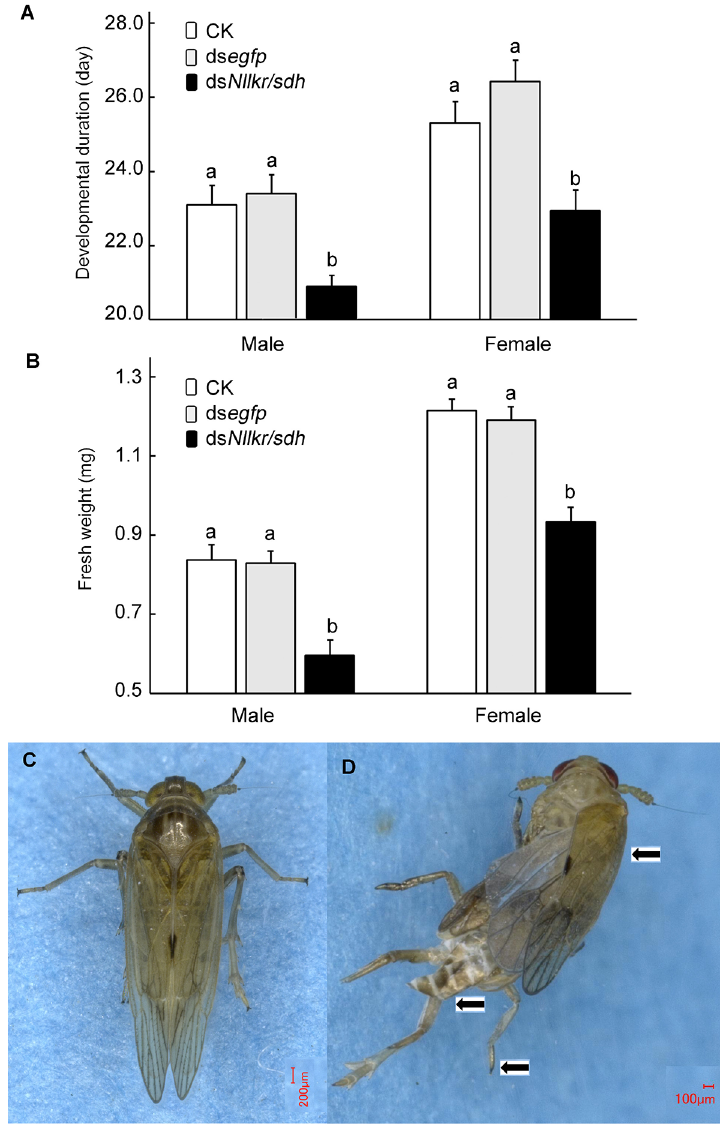
Fig 7. Ingestion of ds Nllkr/sdh negatively affects the development of planthoppers. Dietary introduction of ds Nllkr/sdh shortens the development duration (A), reduces the fresh weight (B), and causes abnormal defects. Two apparent phenotypic defects (D) observed in the resulting adults (C): wings were shortened and thickened, cuticle was semi-transparent, and old nymphal cuticles on the tips of legs and abdomens were not shed off (marked with arrows). The columns represent averages with vertical lines indicating SE. Columns that do not share the same letter are significantly different at P value of 0.05.